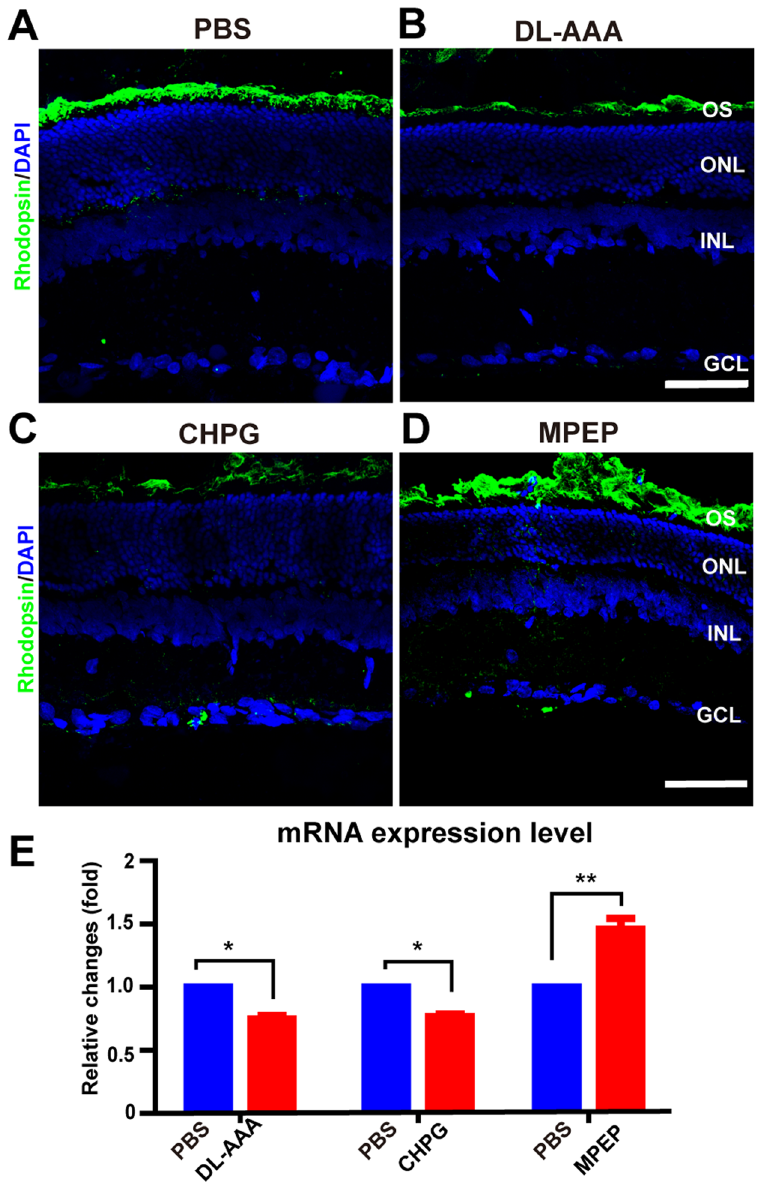
Figure 4. Rhodopsin expression is reduced by DL-AAA and CHPG but increased by MPEP treatment. ( A ) Representative immunofluorescence images showing expression of rhodopsin ( green ) following injection of PBS (control). Nuclear counterstain with DAPI ( blue ). Scale bar = 50 µ m. ( B ) Following DL-AAA injection (7 days). ( C ) Following CHPG injection (2 days). ( D ) Following MPEP injection (2 days). ( E ) Rhodopsin mRNA expression following treatment with DL-AAA, MPEP or CHPG, vs PBS control (n = 3 per bar). Data are shown as mean ± SEM. * p < 0.05, ** p < 0.01. GCL, ganglion cell layer; INL, inner nuclear layer; ONL, outer nuclear layer; OS, outer